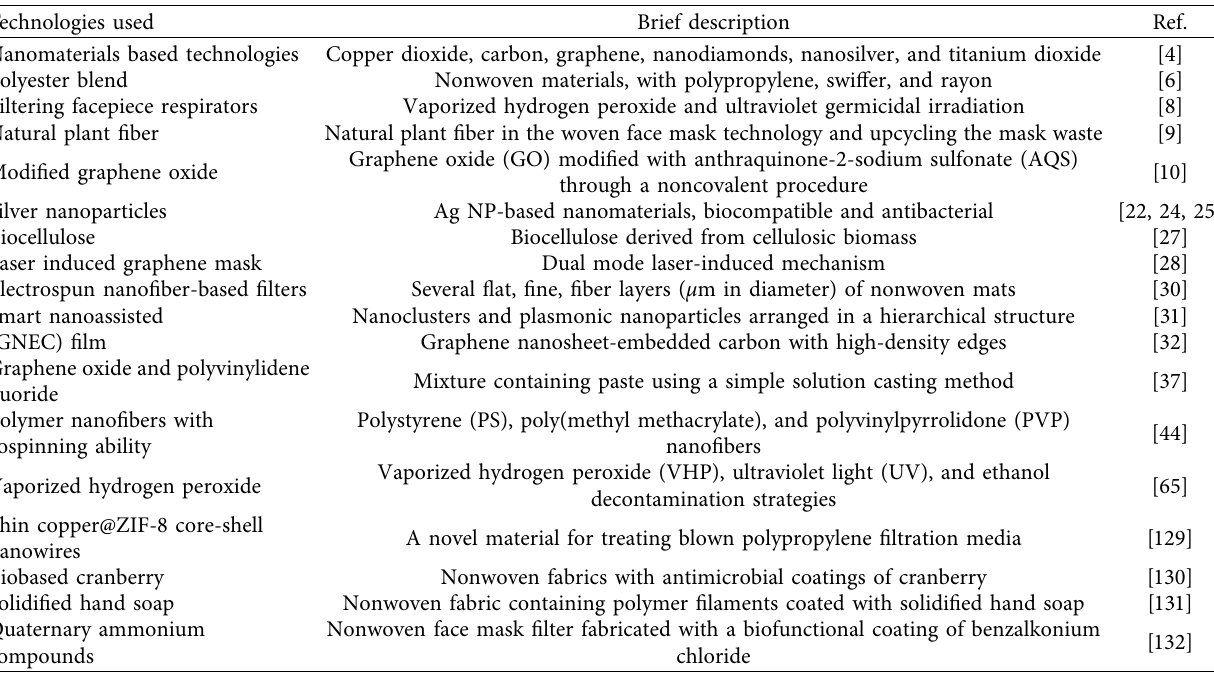
Table 2: A brief summary of technologies used to improve face mask manufacturing. Technologies